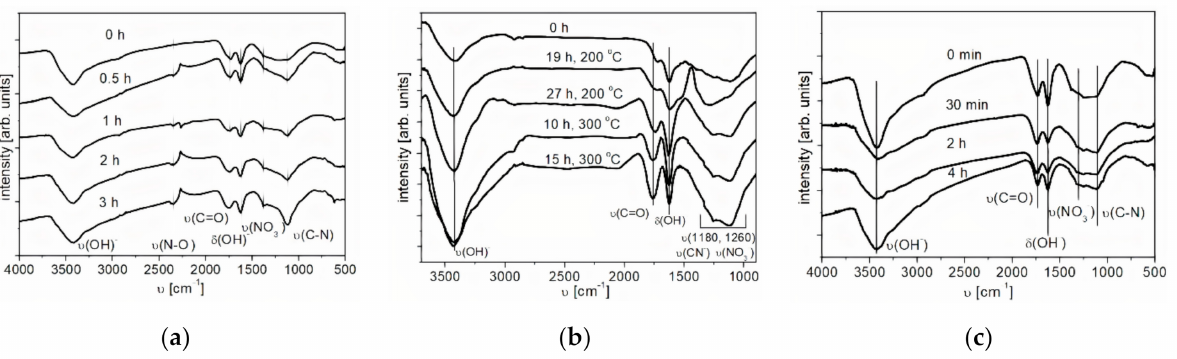
Figure 3. IR spectrum of nanodiamonds (NDs) oxidized by liquid-phase ( a ) and gas-phase ( b ) methods and reduced by H 2 ( c ); υ —stretching vibrations, δ —deformation vibrations.